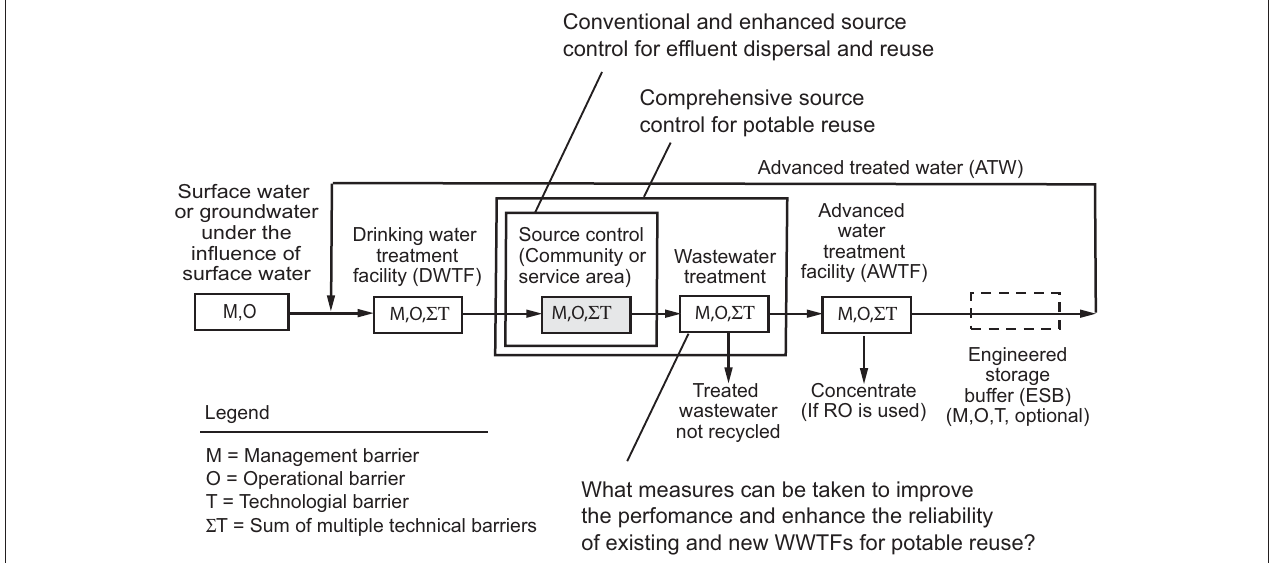
FIGURE 1 | Definition sketch for the boundaries of conventional and enhanced source control programs for effluent dispersal and reuse, and a comprehensive source control program for potable reuse (Adapted from Tchobanoglous et al., 2014).